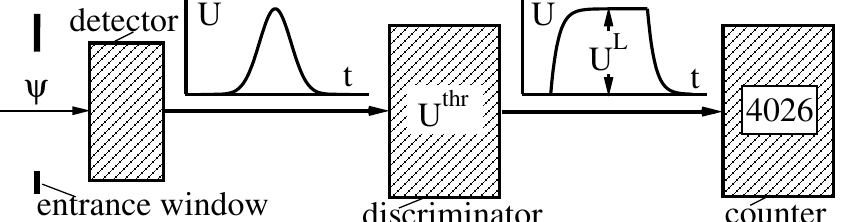
Figure 1. Detection of a single particle or photon. The voltage pulse, U ( t ) , generated by the detector is transformed by the discriminator into a logical output signal, U L , if U ( t ) exceeds the threshold U thr . The output signal, U L , increases the content of the counter memory by one. Here, Ψ denotes the quantum-mechanical state of the incident object, and t is the time. The display of the counter shows the number of particles detected so